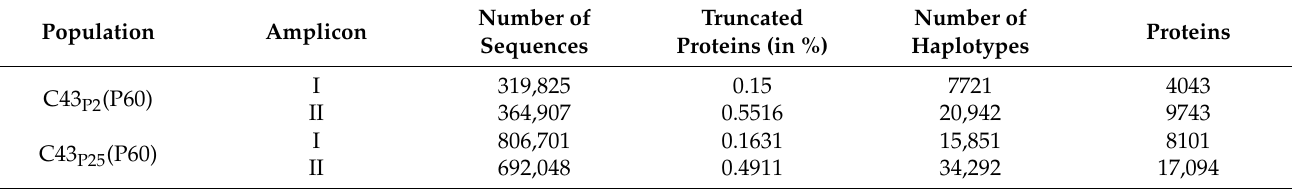
Table 1. Total number of sequences and haplotypes identified through deep sequencing of the two analyzed populations. We show, for each amplicon, the coverage of sequencing (total number of sequences after data processing), the fraction of truncated proteins (those with a non-sense mutation, causing a premature stop codon), the number of different sequences (haplotypes), and the total number of different protein